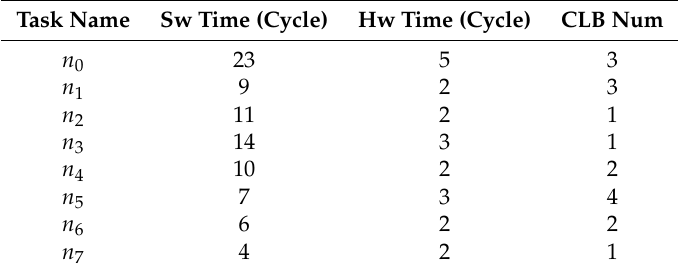
Figure 2. An example DAG. Table 1. Task parameters of the example DAG. num,